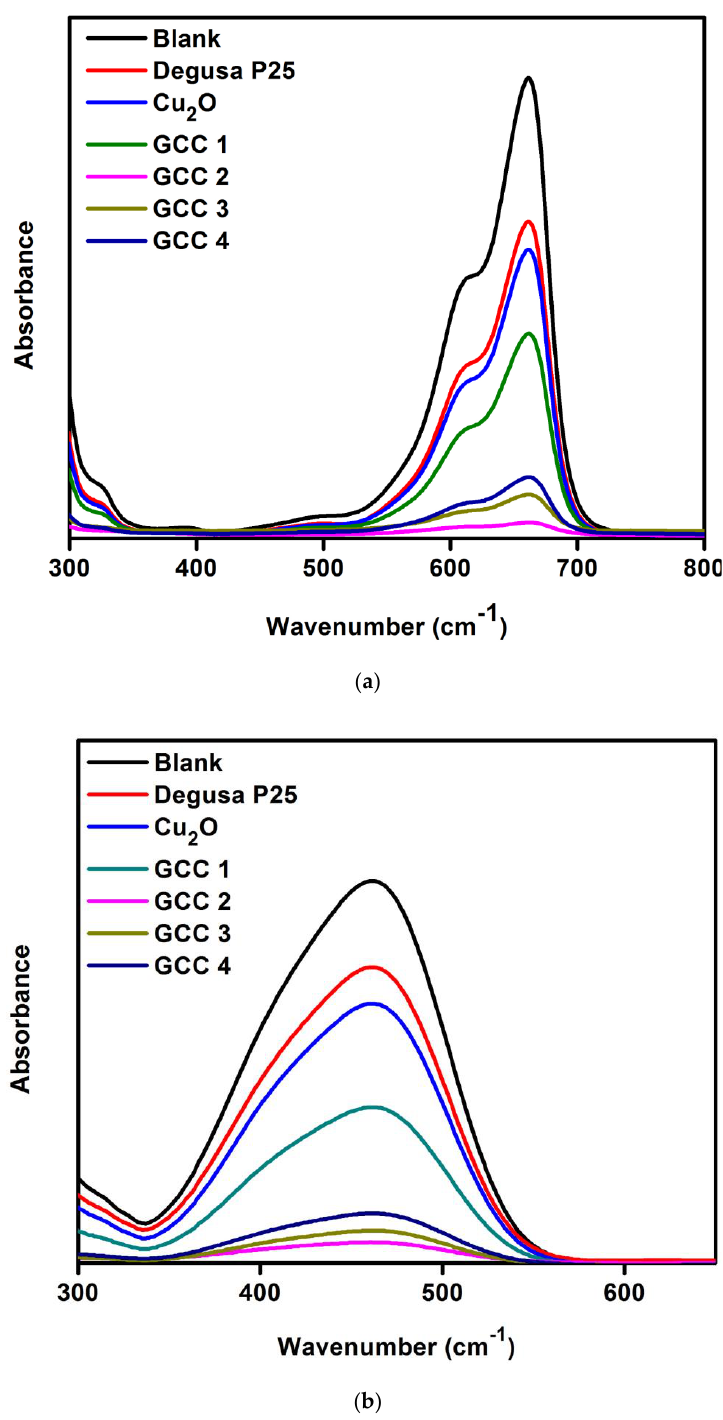
Figure 11. ( a )UVspectrumofmethylenebluedegradation. ( b